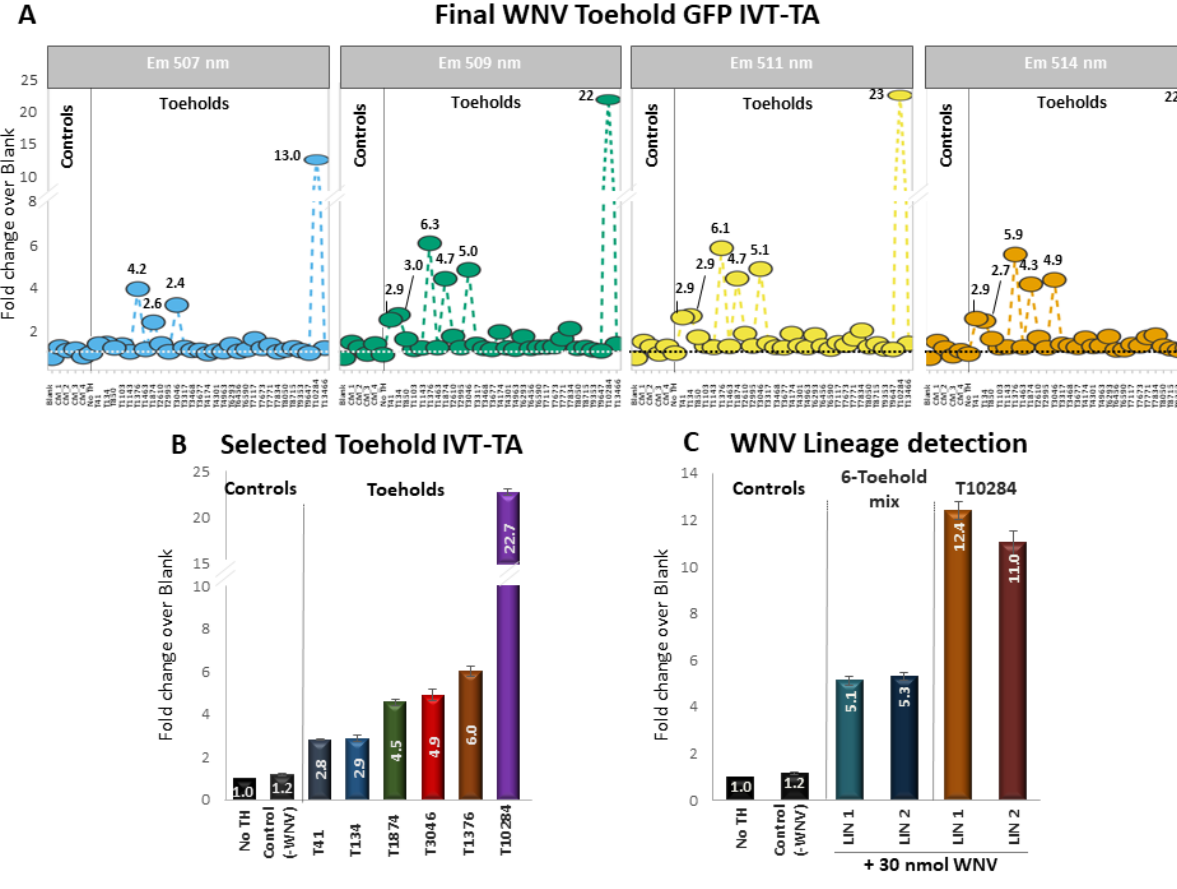
Figure 3. In vitro trials of WNV toehold switches ( A ) Individual in vitro Transcription/Translation (IVT-TA) trials of thirty selected GFP-toeholds of WNV. Signal detection was performed in four different channels, corresponding to 507 (blue), 509 (green), 511 (yellow) and 514 (orange) nm across the GFP emission spectrum. Y-axis shows fold enrichment of GFP detection compared to the average of negative controls. Negative controls include IVT-TA trials of different toeholds mixes in the absence of trigger RNA and IVT-TA without any WNV toehold in the presence of 100 ng WNV RNA. ( B ) Independent biological repetitions of the selected toeholds using 100 ng of WNV lineage 2 genomic RNA trigger ( C ) IVT-TA trials of mixed WNV toeholds using both lineage 1 and 2 isolated RNA as trigger. In addition, T10284 that outperformed all other toeholds was also tested individually against both lineage triggers.